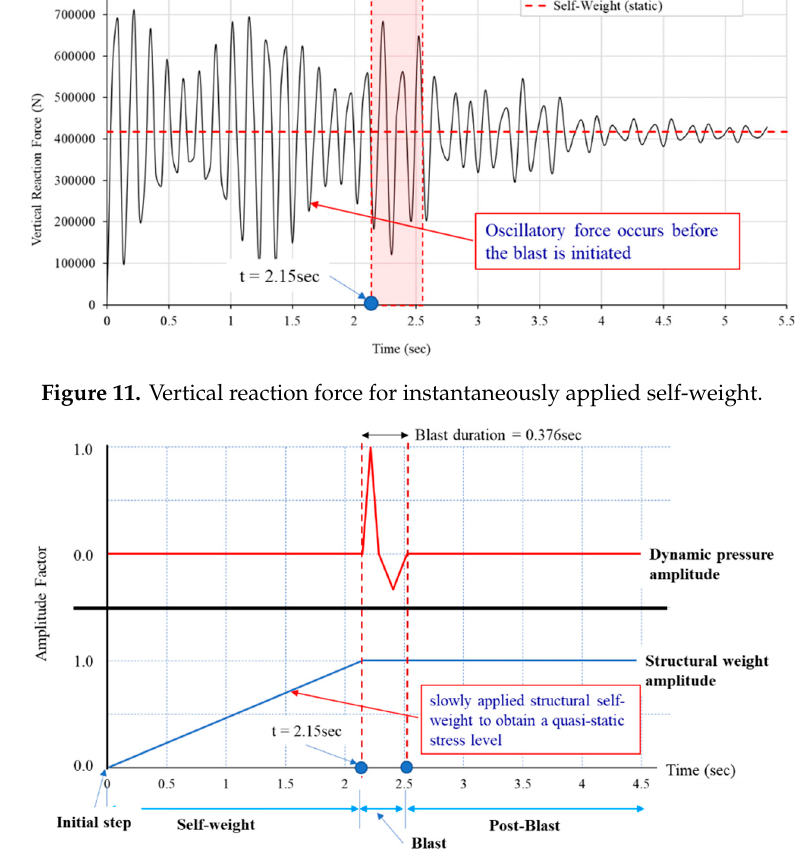
Figure 12. Dynamic analysis steps and durations.